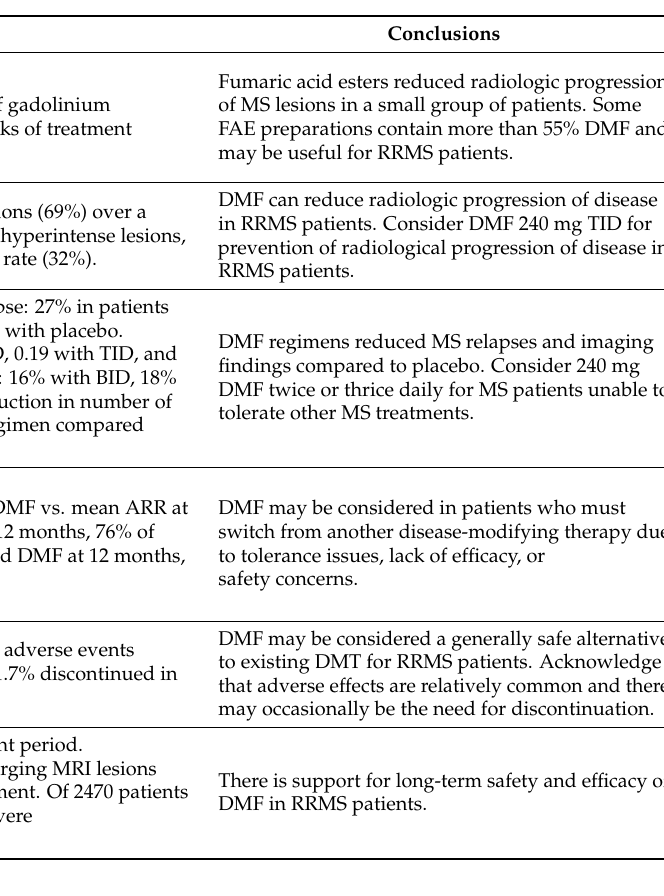
Table 1. Clinical efficacy and